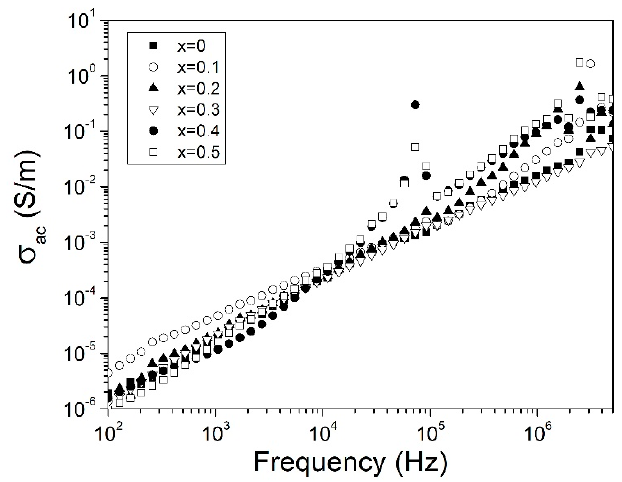
Figure 7. Alternating current conductivity ( σ AC ) at room temperature of Y 1 − x Bi x FeO 3 varying x from 0 to 0.5, of pellets sintered at 700 °C.